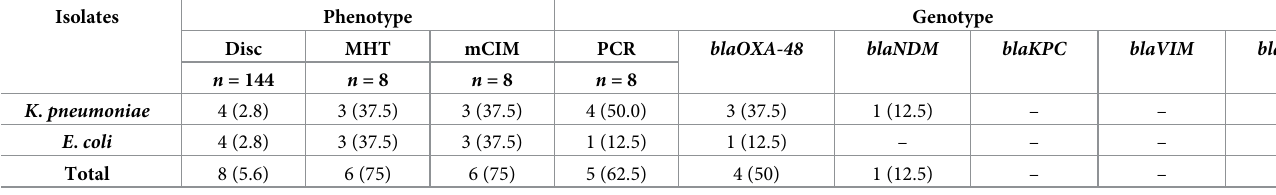
Table 4. Summary of Results on the phenotypic and genotypic detection of carbapenem resistance.